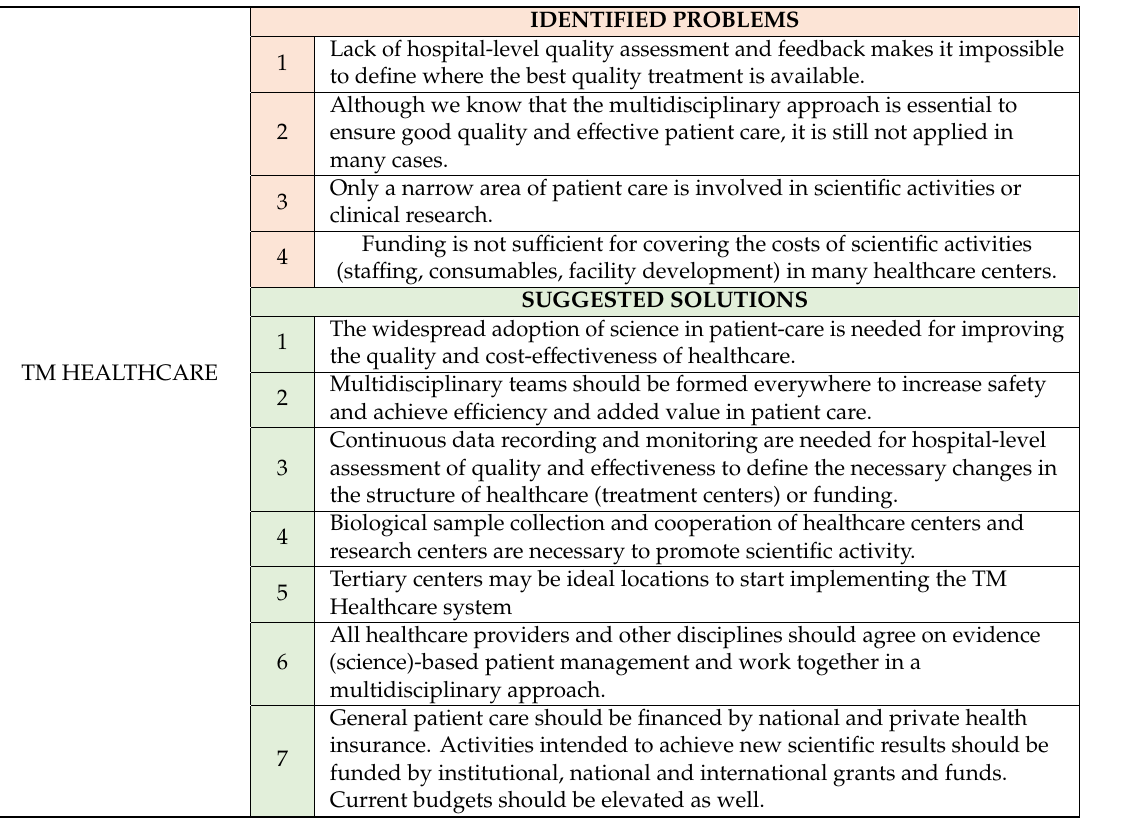
Table 1. Identified problems and suggested